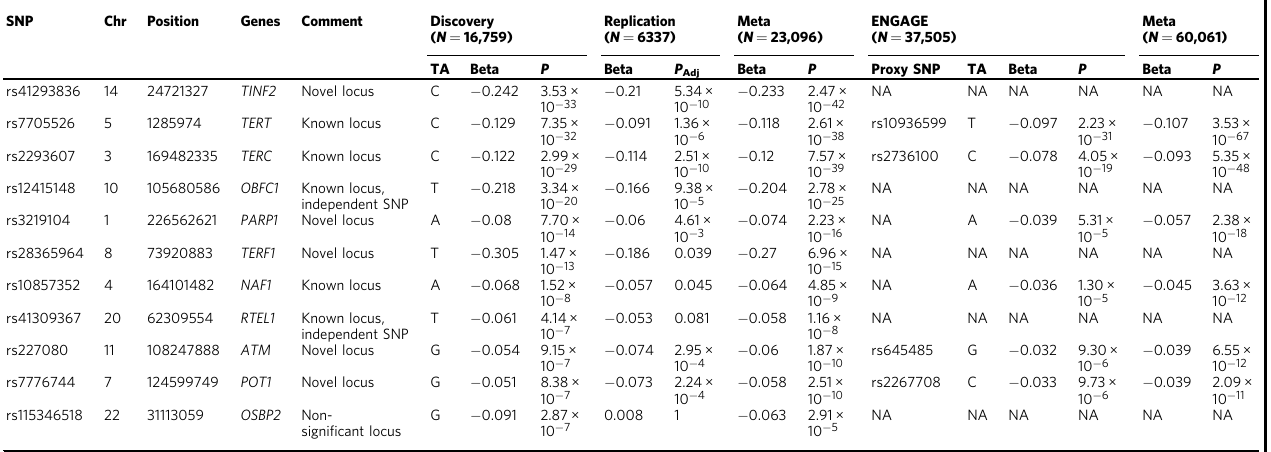
Table 1 Summary statistics of genome-wide hits identi fi ed within the SCHS study SNP